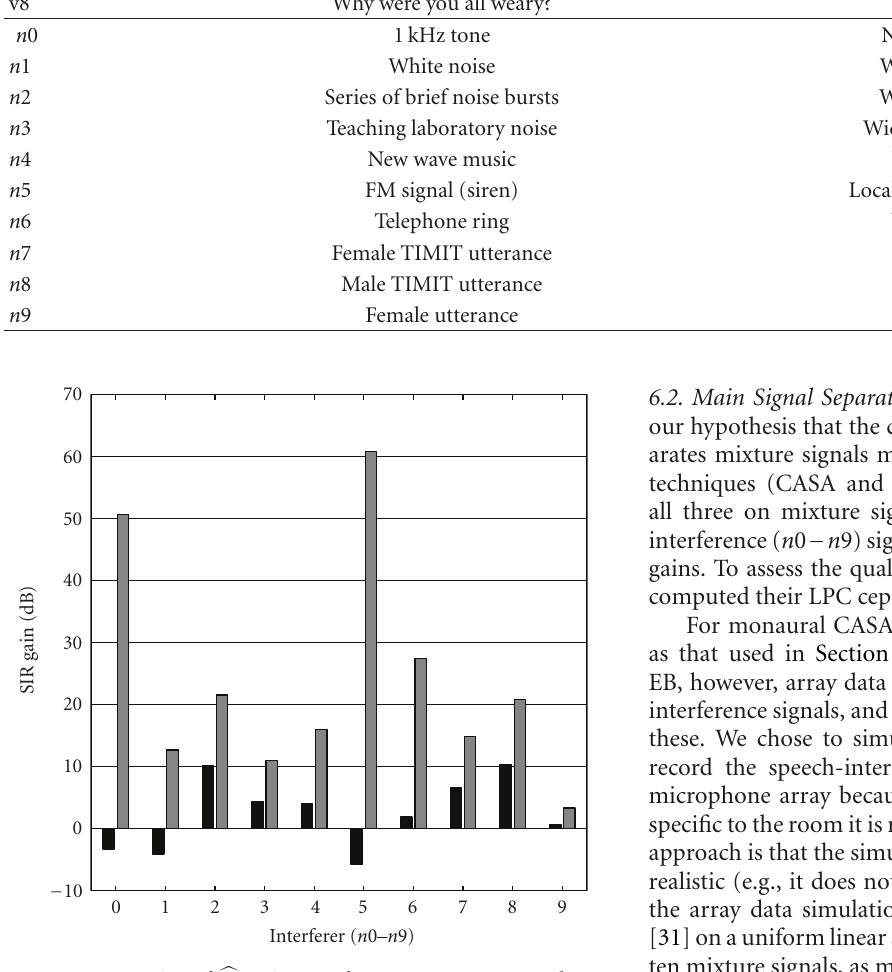
Figure 7: SIR gains of (cid:30) v 8 estimates, from Wang, Brown, and van der Kouwe et al.’s monaural CASA. The horizontal axis specifies the test mixture by its interferer. The two lines shown for each indicate the SIR of v 8 in the mixture (black), and the SIR of the separated (cid:30) v 8